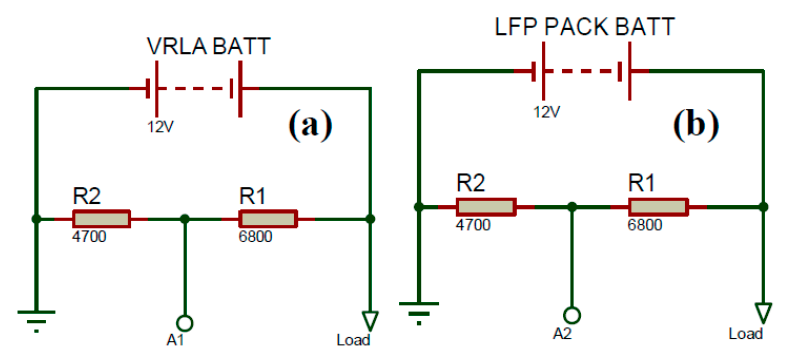
Figure 2. Voltage sensor at each battery ( a ) VRLA battery; ( b ) LFP battery.